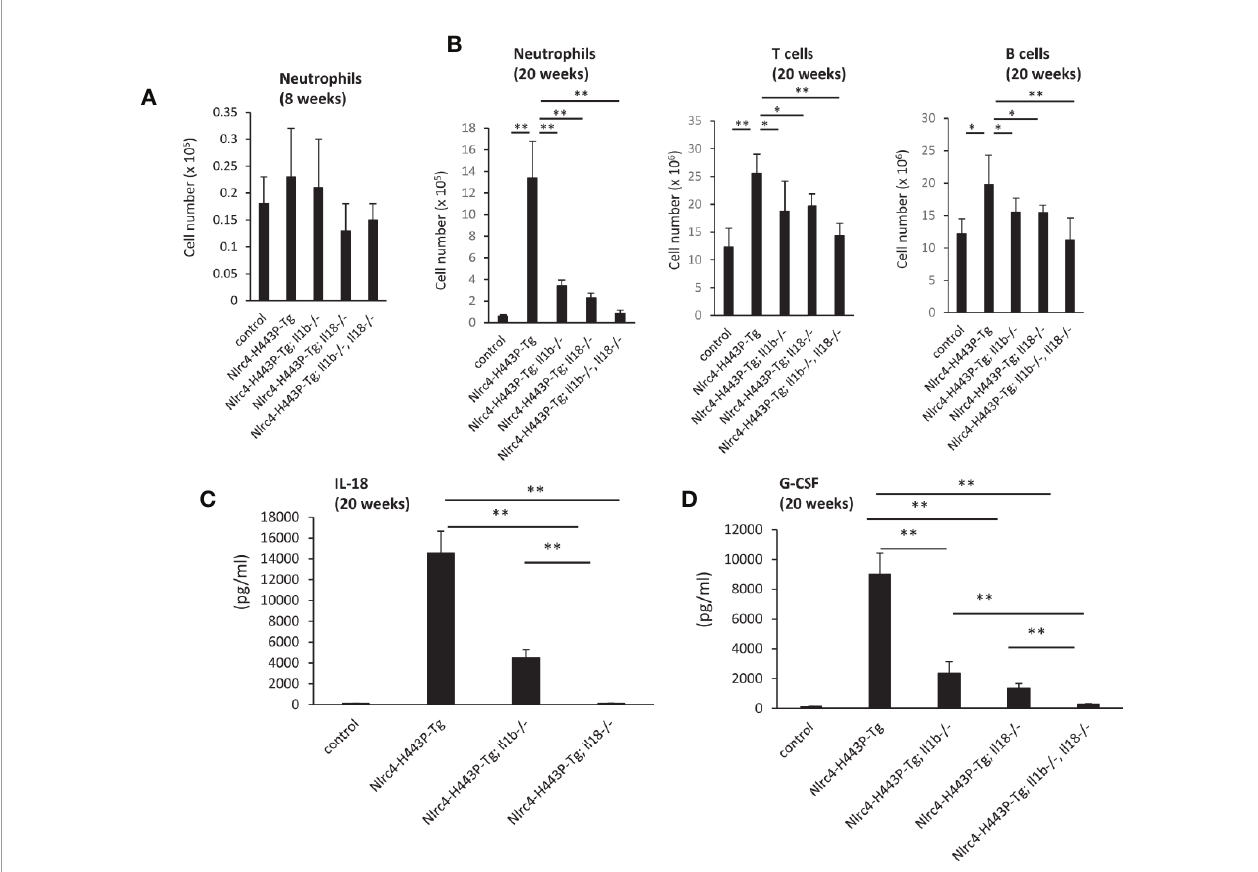
FIGURE 1 | IL-1 b – and Il-18 – mediated in fl ammation in Nlrc4-H443P-Tg mice. (A) Total neutrophil numbers in the spleens of control, Nlrc4-H443P-Tg, Nlrc4- H443P-Tg/Il1b − / − , Nlrc4-H443P-Tg/Il18 − / − , and Nlrc4-H443P-Tg/Il1b − / − Il18 − / − mice at the age of 8 and weeks were determined (N = 8 in each group). The neutrophils were de fi ned as CD11b+Gr-1 high cells. The data are shown as the mean ± SD. *P < 0.05; **P < 0.01. (B) Total neutrophil, T cells or B cells numbers in the spleens of control, Nlrc4-H443P-Tg, Nlrc4-H443P-Tg/Il1b − / − , Nlrc4-H443P-Tg/Il18 − / − , and Nlrc4-H443P-Tg/Il1b − / − Il18 − / − mice at the age of 20 weeks were determined (N = 8 in each group). The data are shown as the mean ± SD. *P < 0.05; **P < 0.01. Serum (C) IL-18 was measured in control, Nlrc4-H443P-Tg, Nlrc4- H443P-Tg/Il1b − / − and Nlrc4-H443P-Tg/Il18 − / − mice at the age of 20 weeks (N = 5 in each group), and serum (D) G-CSF was measured in control, Nlrc4-H443P-Tg, Nlrc4-H443P-Tg/Il1b − / − , Nlrc4-H443P-Tg/Il18 − / − , and Nlrc4-H443P-Tg/Il1b − / − Il18 − / − mice at the age of 20 weeks (N = 5 in each group). Data are shown as the mean ± SD. **P <